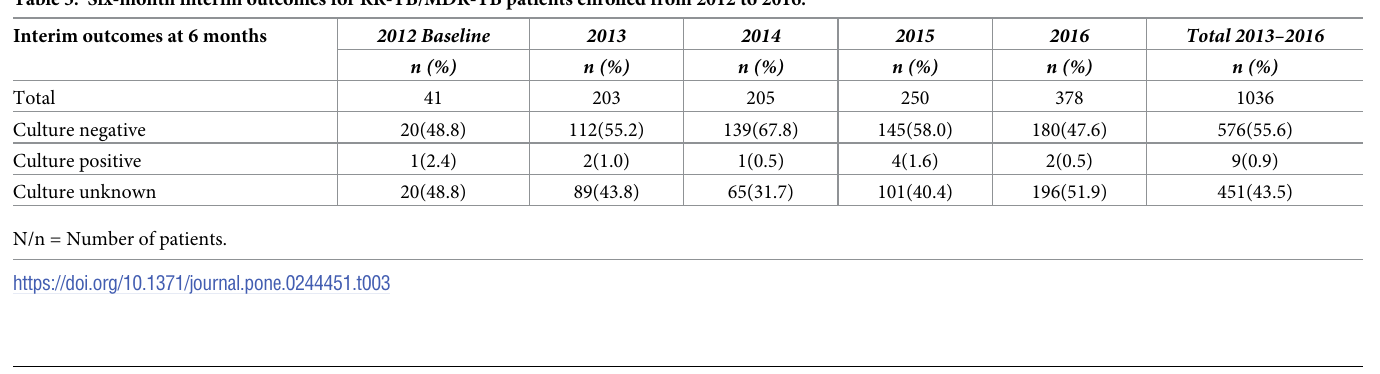
Table 3. Six-month interim outcomes for RR-TB/MDR-TB patients enrolled from 2012 to